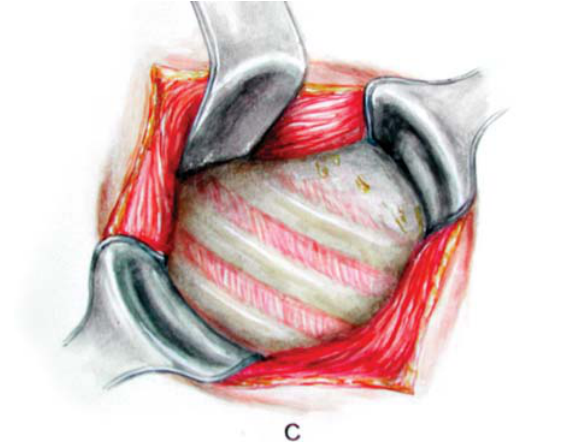
Fig. 3 - Trígono auscultatório com sua musculatura afastada e costelas